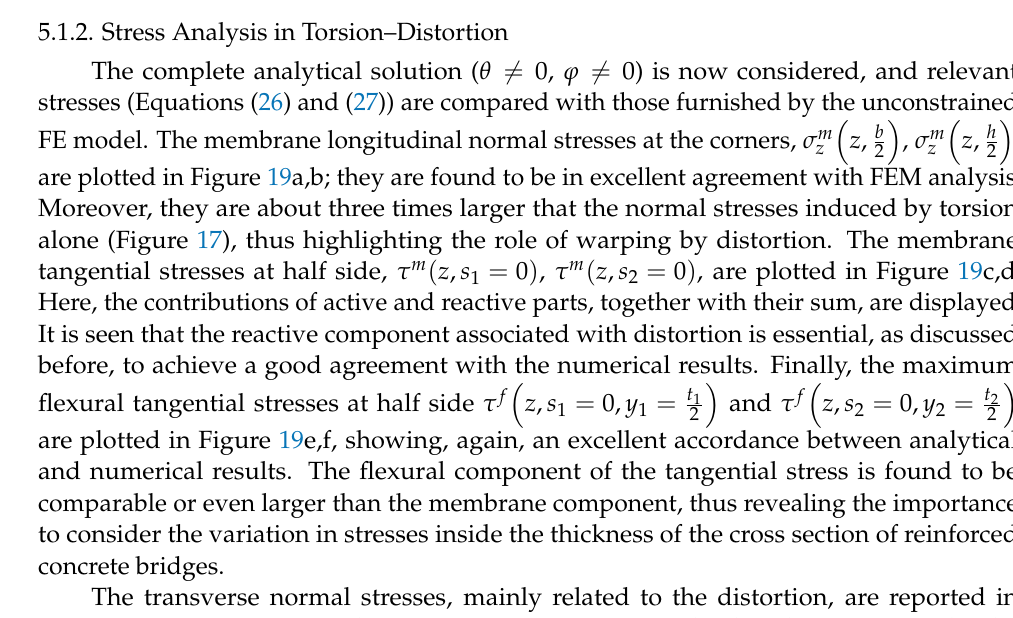
Figure 18. Torsion without distortion: Reactive tangential stresses τ mr at z = 11.25m vs. s i : ( a ) element 1, ( b ) element